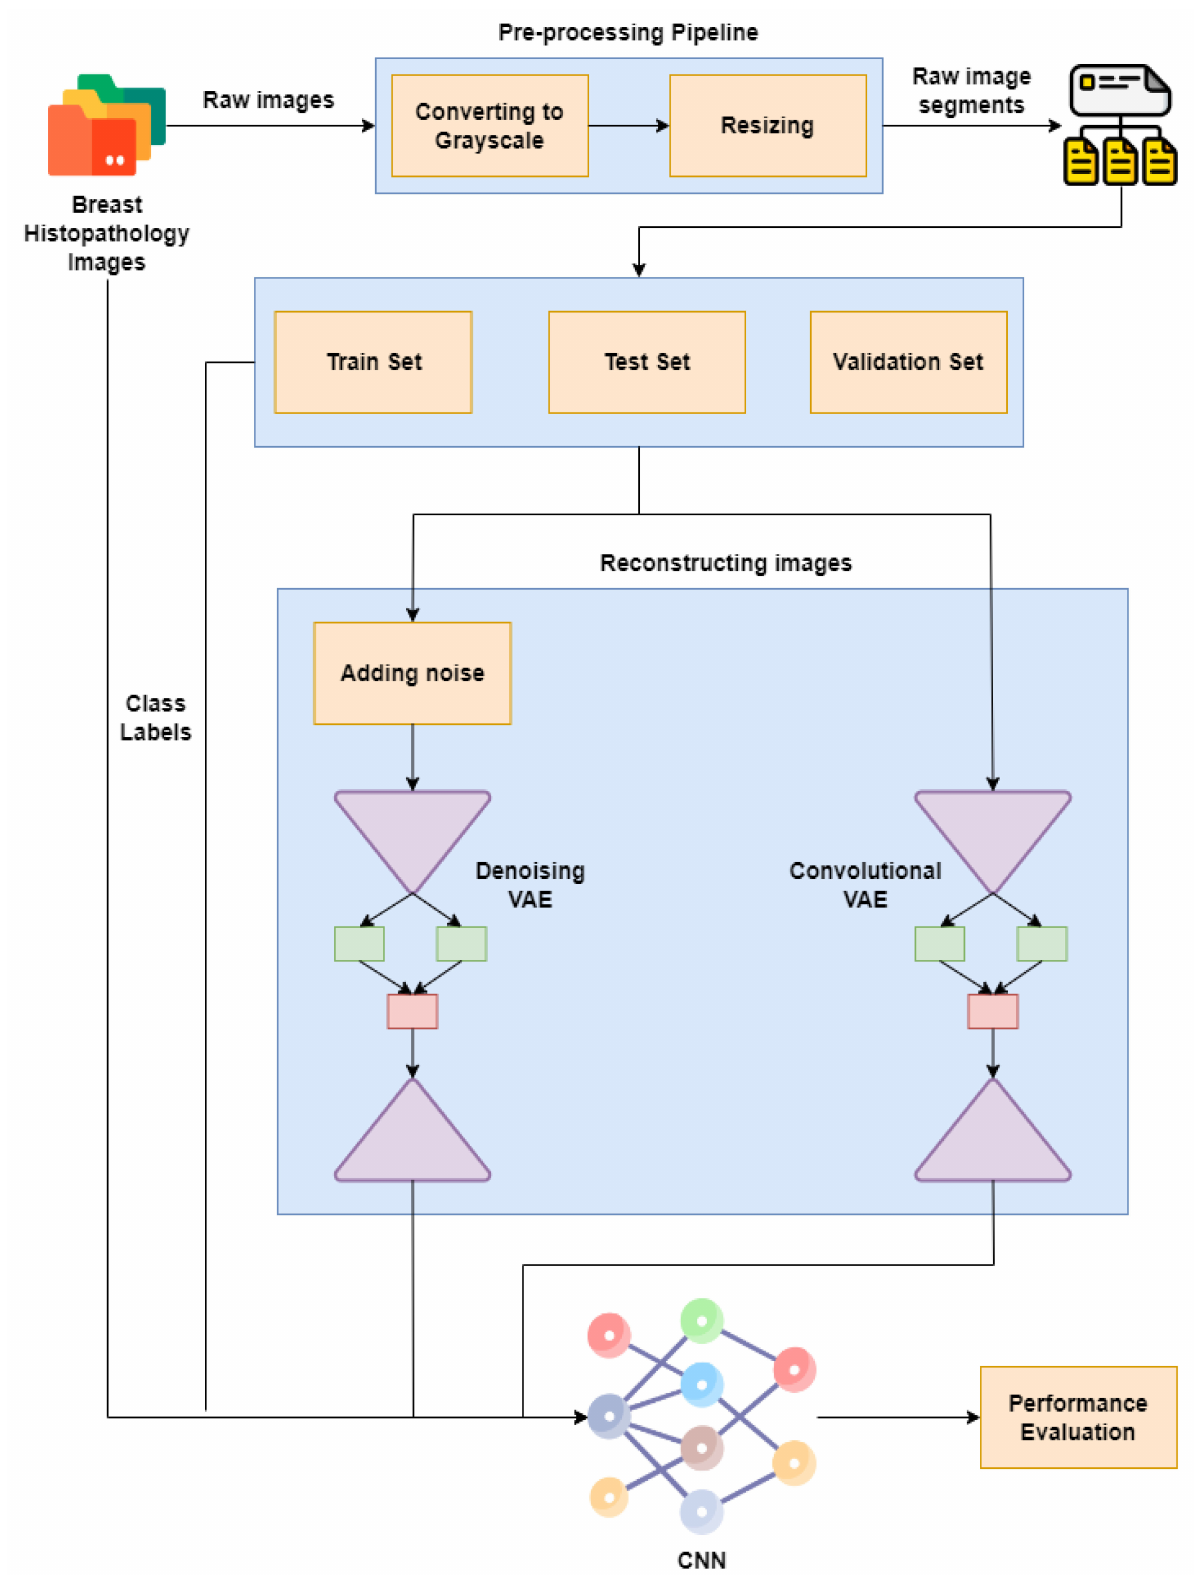
Figure 1. Proposed implementation